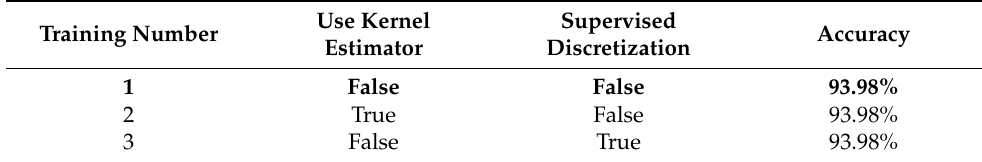
Table 8. NB algorithm hyperparameter optimization results using the Kernel Estimator and the Supervised Discretization